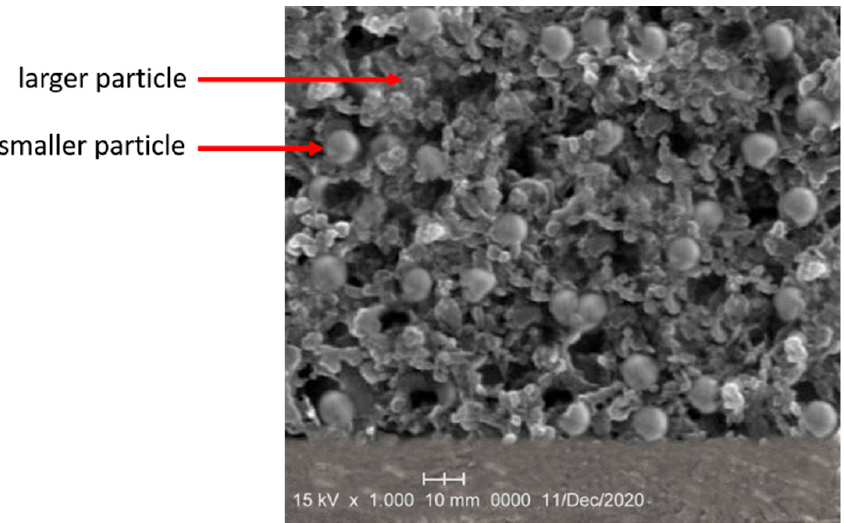
Figure 3. An SEM image of the composite membrane.